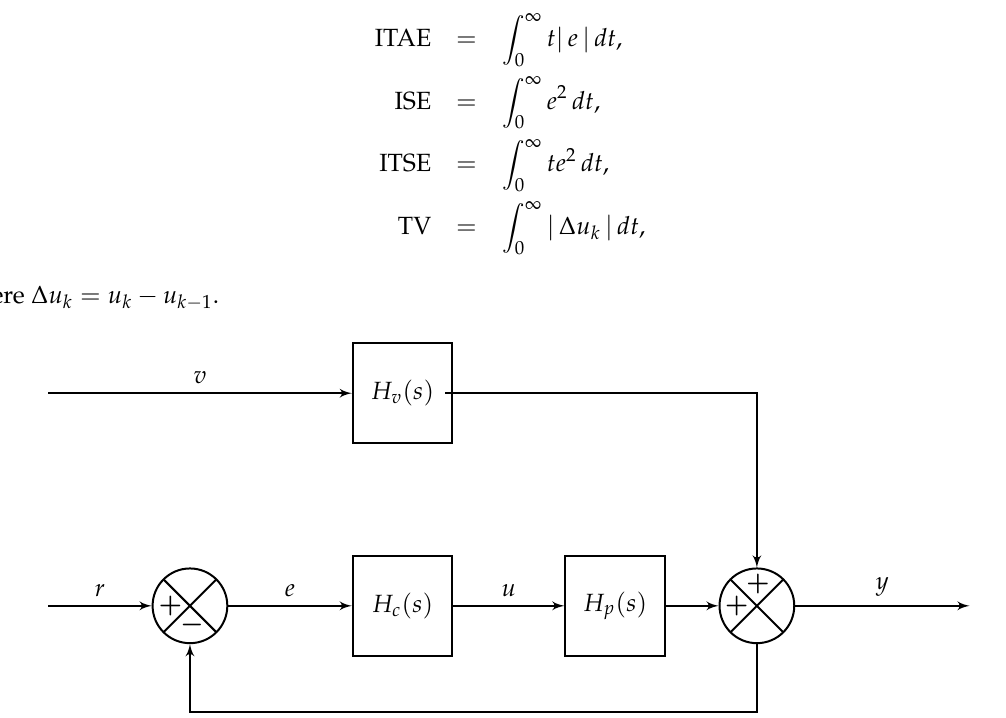
Figure 2. Consider a control feedback system where the plant model is described by the process